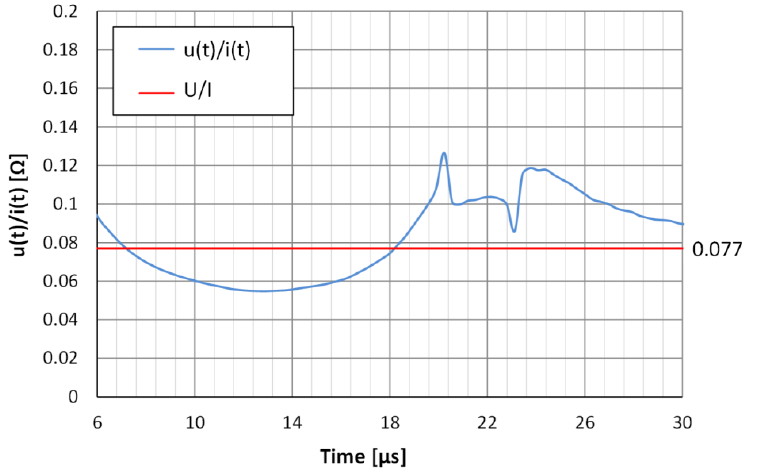
Figure 11. Transient resistance of the CFRP3 sample during the test with the last impulse (in blue) versus surge impedance Z = U/I (in red).